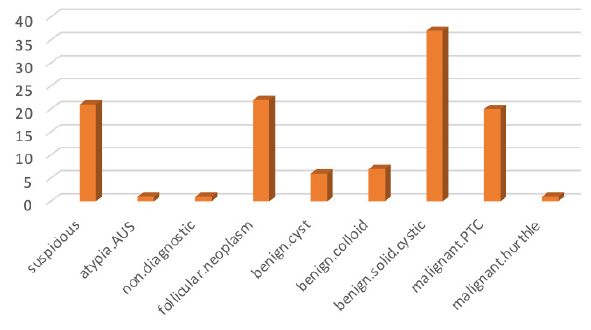
Figure 1: Frequency comparison of FNA results.